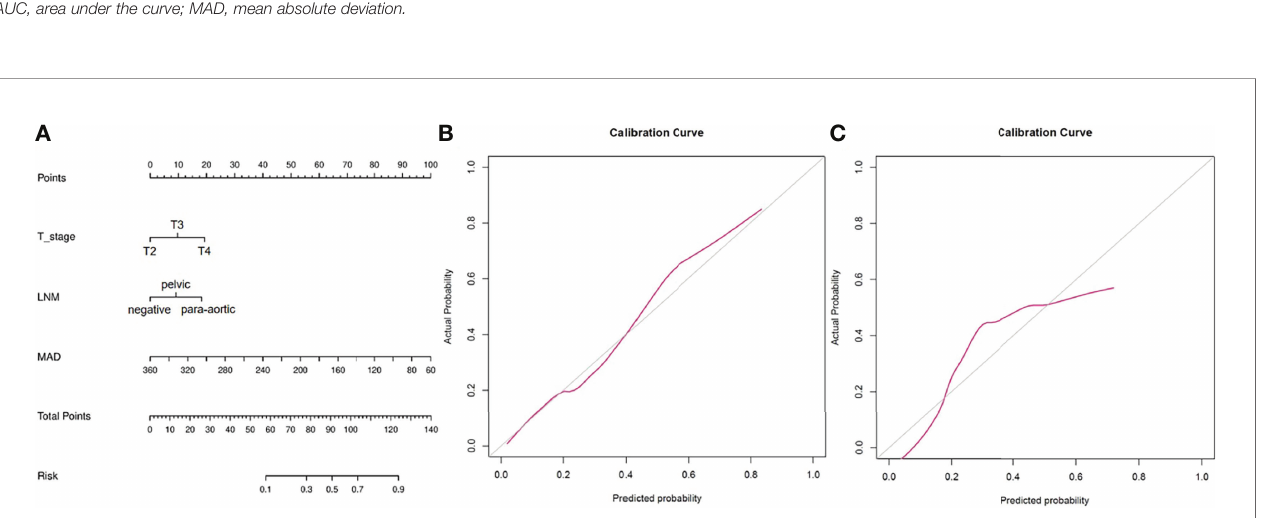
AUC, area under the curve; MAD, mean absolute deviation.